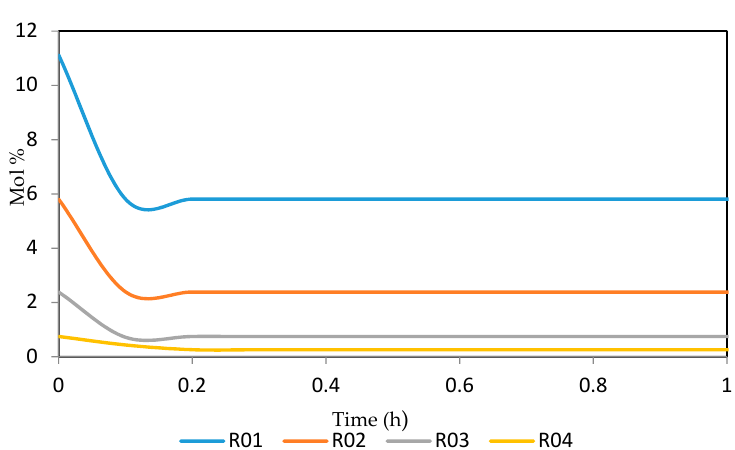
Figure 23. Dynamic behaviour of N 8 in the four